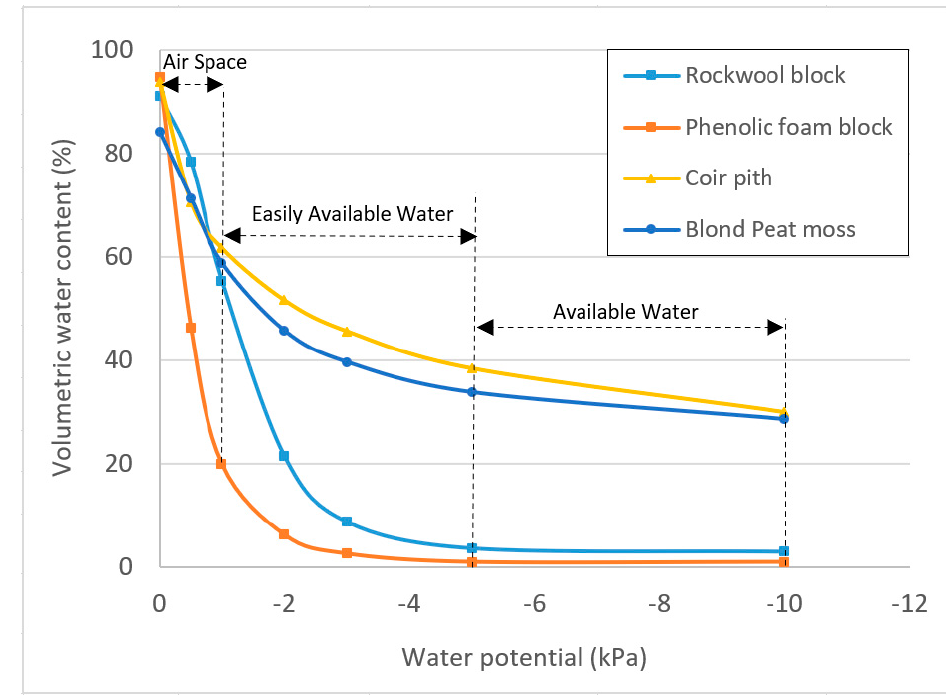
Figure 2. Moisture retention curves for selected soilless growing media. Table 2. Physical properties of the selected materials adjusted for a height of 14 cm.